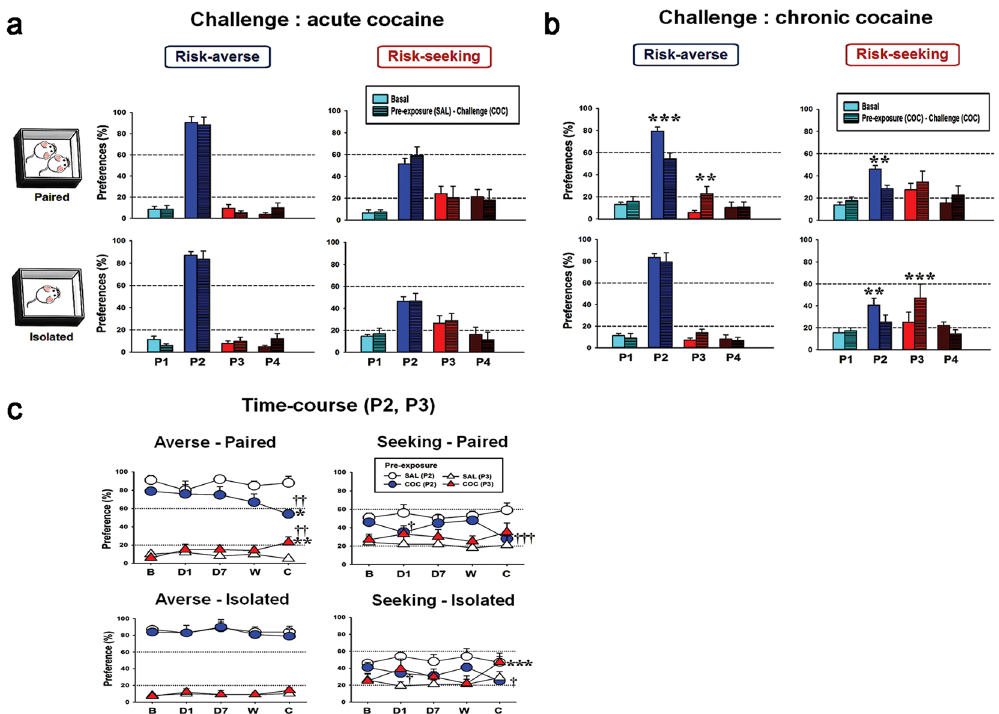
Figure 3. Preference scores after cocaine challenge. ( a ) The cocaine challenge in saline pre-exposed rats did not make any differences in the risk preferences compared to their basal scores. The numbers of rats in each group were as follows: averse-paired (7), averse-isolated (10), seeking-paired (6), and seeking-isolated (8). ( b ) In response to the cocaine challenge, when they were cocaine pre-exposed, all rats, except those in the averse- isolated group, had a more risk-seeking choice preference (i.e., they chose P2 less and P3 more). The numbers of rats in each group were as follows: averse-paired (7), averse-isolated (7), seeking-paired (8), and seeking- isolated (6). Values are expressed as a mean + standard error of mean. ( c ) In the saline and cocaine pre-exposed groups, the preference scores for only P2 and P3 obtained during the tests conducted at basal (B), pre-exposure day 1 (D1), pre-exposure day 7 (D7), the withdrawal period (W), and challenge day (C) are depicted. Again, it is clear that all rats, except those in the averse-isolated group, had more risk-seeking choice preference (i.e., they chose P2 less and P3 more) in response to the cocaine challenge, when they were pre-exposed to cocaine. Two- way repeated-measures ANOVA was conducted on data for P2 and P3 separately, but they were drawn together on the same graph for easy